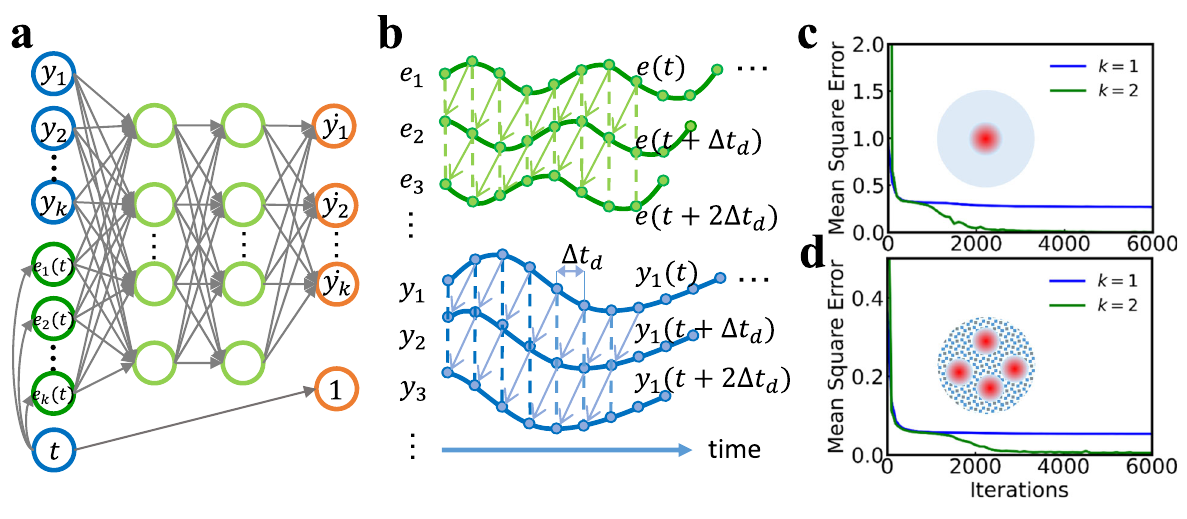
Fig. 2 Extending the Neural ODE formalism to predict spintronic results. A wide range of dynamical systems can be modeled using ODEs, such as the simple pendulum motion, skyrmion-based devices, and spintronic oscillator dynamics. However, in real-world applications, the underlying physical dynamics are not always fully measurable, or accessible, which means that the dynamics of some hidden parameters in ODEs models are unknown. Our goal is to model a Neural ODE, _ y ¼ f θ ð y ; e ð t Þ ; t Þ , where f is de fi ned by a neural network and e ( t ) is the time-dependent input into the system, using the incomplete information of the system dynamics. a Schematic graph of the neural network ( f θ ) in a Neural ODE. The input to the neural network consists of two parts, one is the k dimensional vector related to the observed system dynamics, where y 1 is the observed dynamics and y 2 to y k are the time-delayed dynamics of y 1 (as shown in b ), another part comprises the time-dependent external inputs, in which e 1 is the original input and e 2 to e k are the time- delayed versions of e 1 . The output of the neural network is a vector of time derivatives of the corresponding input system dynamics ( y 1 , y 2 , … , y k , t ). Here, the derivative of the time variable t is 1, which is determined as a prior knowledge. b Illustration of the time-domain system dynamics and external time- dependent input dynamics used for modeling the Neural ODEs. The blue curves are the system dynamics, where y 1 is the original observed trajectory, y = y t + Δ t d ) is one time step shifted of y y = y t + 2 Δ t d ) is two time steps shifted of y Δ t d denotes the single time delay interval. The 2 1 ( 1 , 3 1 ( 1 , etc. Here, green curves are the external inputs, where e 1 = e ( t ) is the original input dynamics, e 2 = e ( t + Δ t d ) is one time step shifted of e 1 , e 3 = e ( t + 2 Δ t d ) is two time steps shifted of e 1 , etc. Through the augmentation, the reconstructed system dynamics ( y 1 , y 2 , y 3 , . . ., y k ) containing the information of the unknown state variables can be used to train the Neural ODEs and then the trained Neural ODEs can be applied to make predictions for other inputs. c , d Training error (Mean Square error, MSE) as a function of iterations for k = 1 and k = 2 for a one-skyrmion system ( c ) and a multi-skyrmions system with grain inhomogeneity ( d ) with electric voltage as input through the VCMA